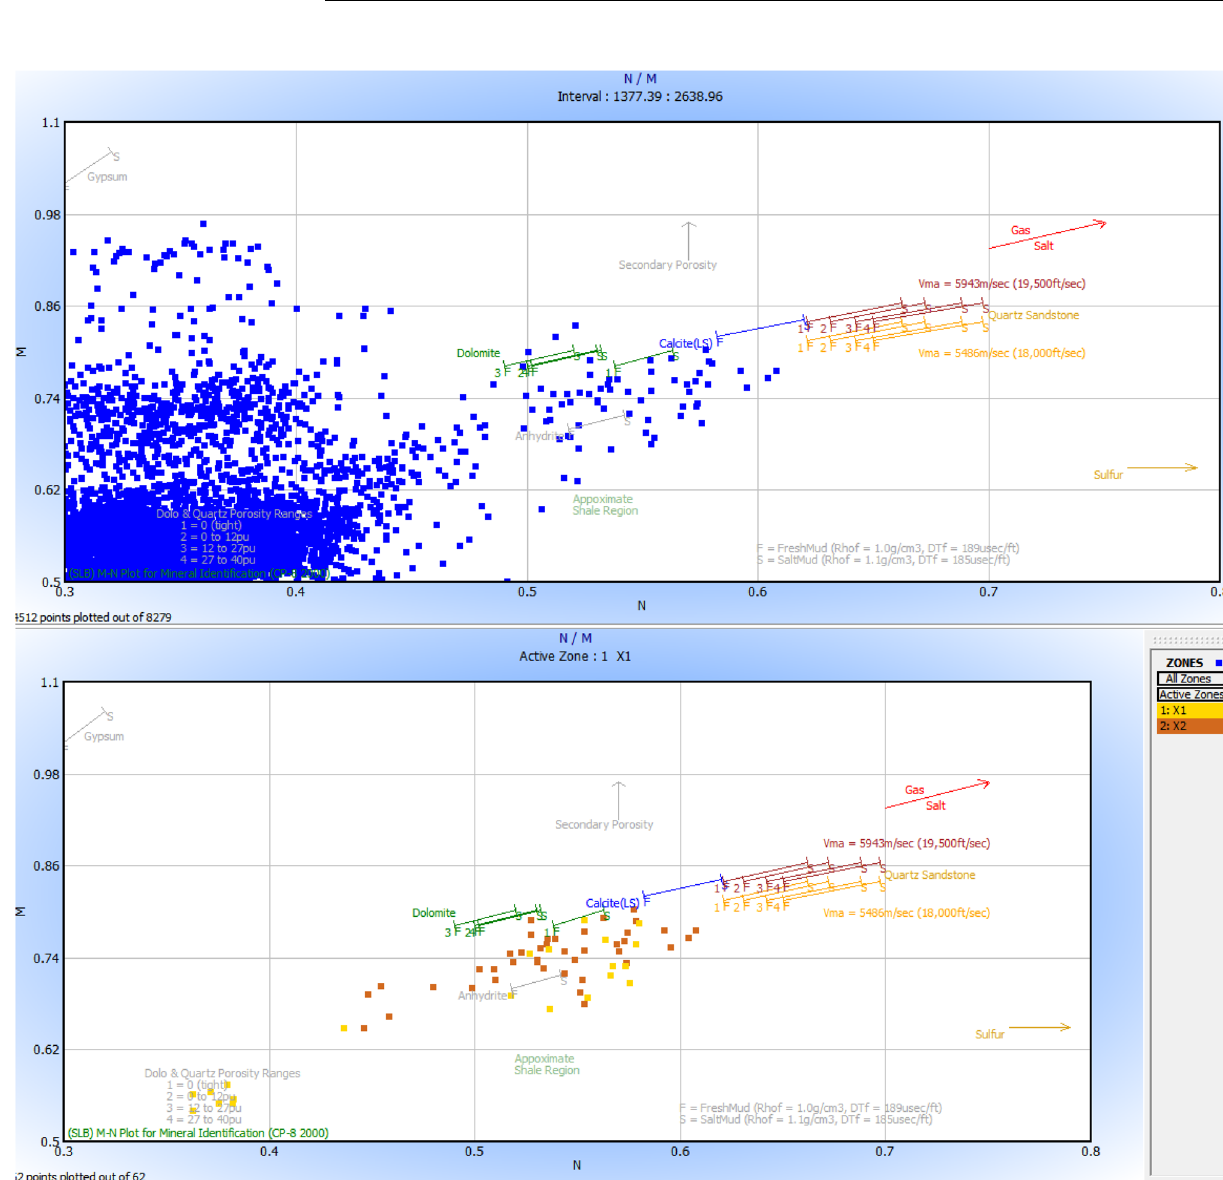
Fig. 7 M–N Lithology Plots for Well X reservoir interval with most of the points plot within the dolomite and calcite